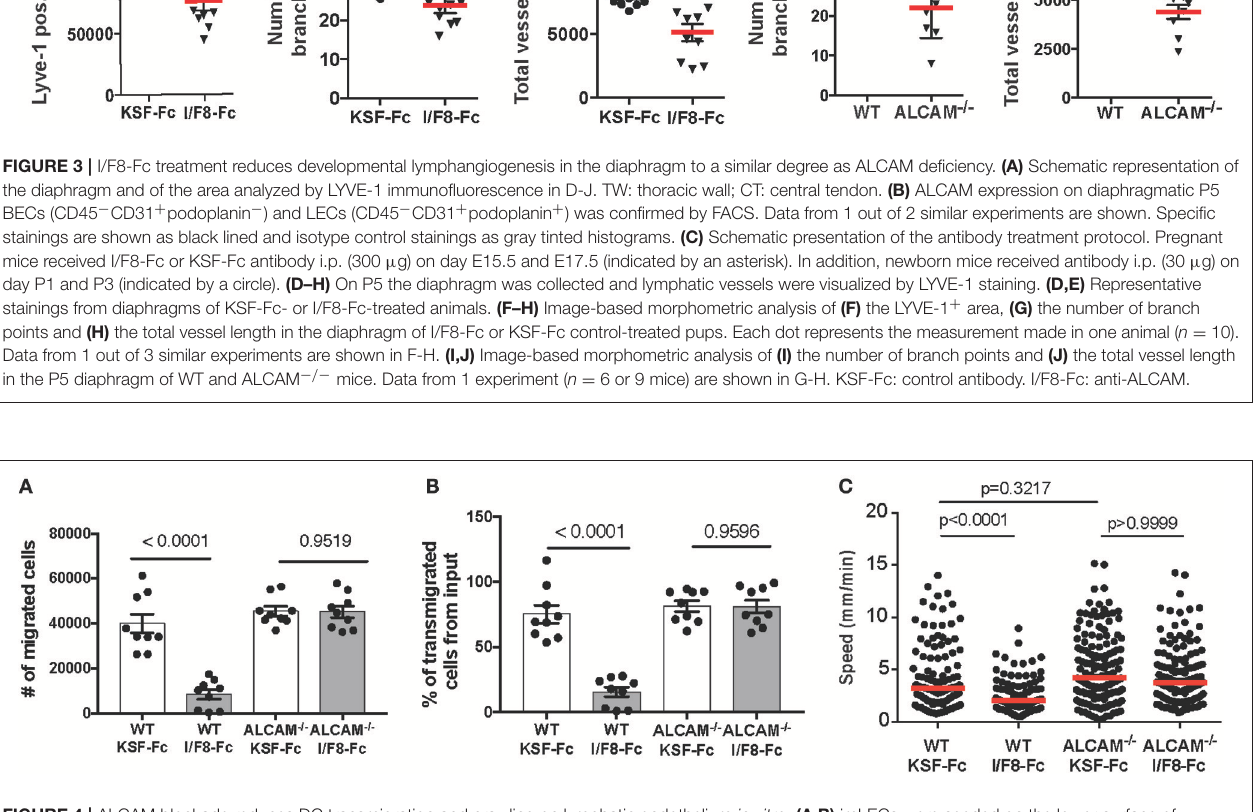
Frontiers in Immunology |